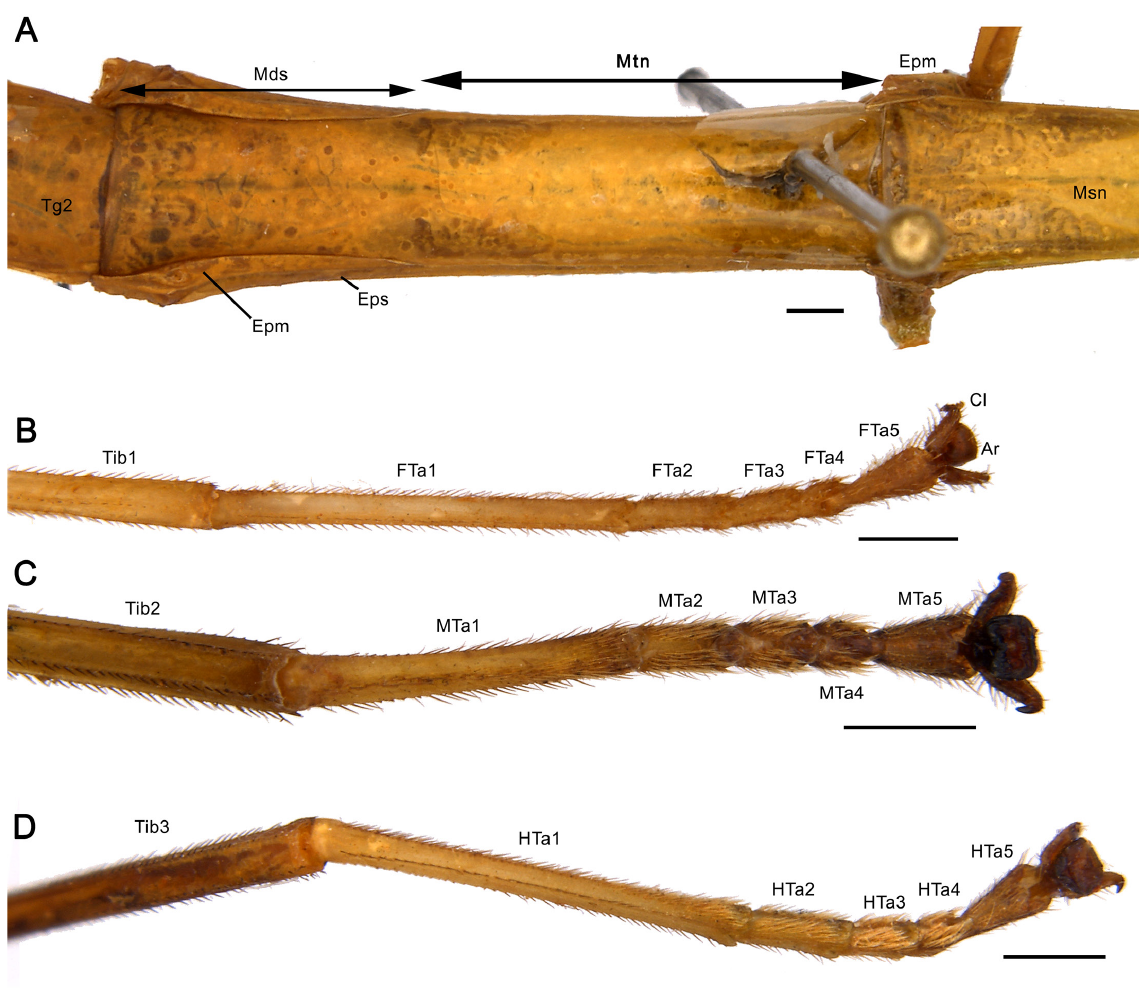
Fig. 16. Arumatia anyami Ghirotto, Crispino & Neves gen. et sp. nov., holotype, ♀ (MZUSP 1091), thorax and leg morphology. A . Metathorax and median segment in dorsal view, arrows indicate the length of each segment. B . Right fore tarsus, dorsal view. C . Right mid tarsus, ventral view. D . Right hind tarsus, posteroventral view. Abbreviations: Ar = arolium; Cl = claw; Epm = epimeron; Eps = episternum; FTa = fore tarsomere; HTa = hind tarsomere; Mds = median segment; Msn = mesonotum; MTa = mid tarsomere; Mtn = metanotum; Tg = tergum; Tib = tibia. Scale bars: 1